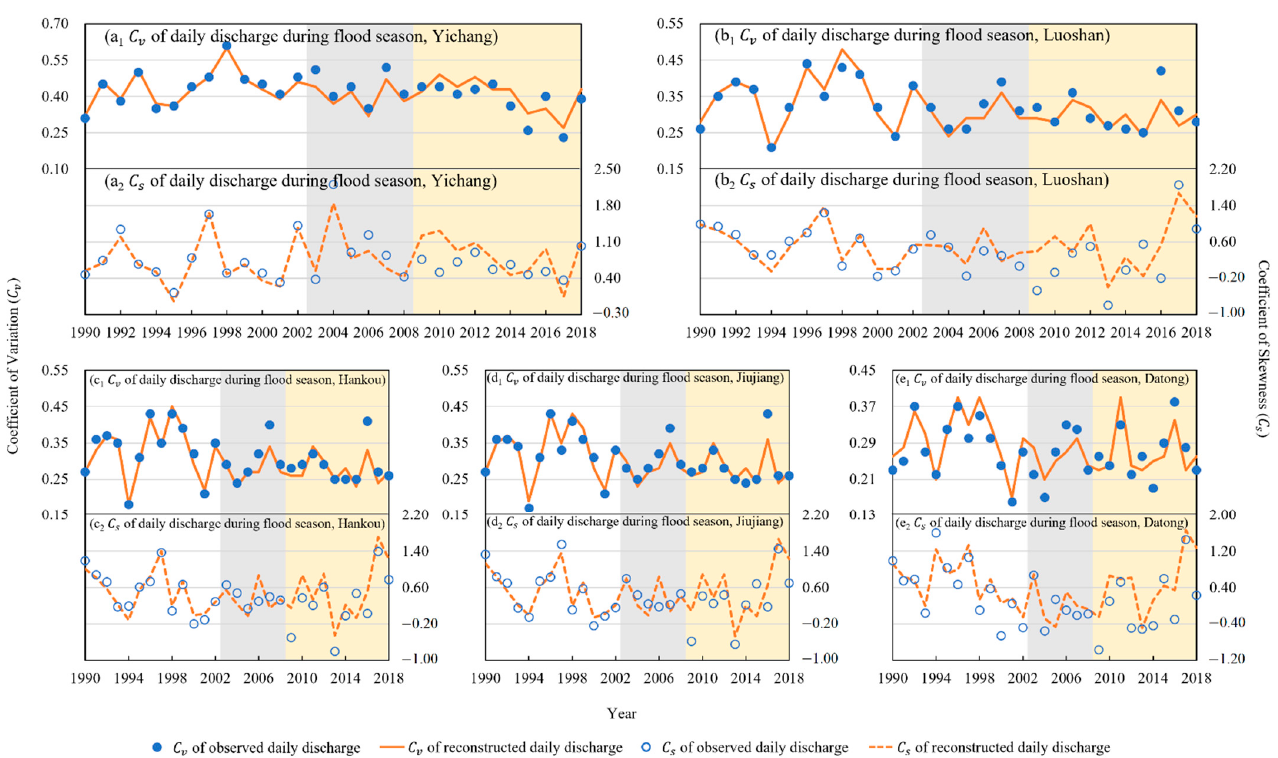
Figure 15. Analysis of C v and C s of daily discharge during flood season in the five gauging stations (the grey zones denote the initial operation period of the TGD from 2003 to 2008, and the yellow zones denote the full operation period of the TGD from 2009 to 2018).